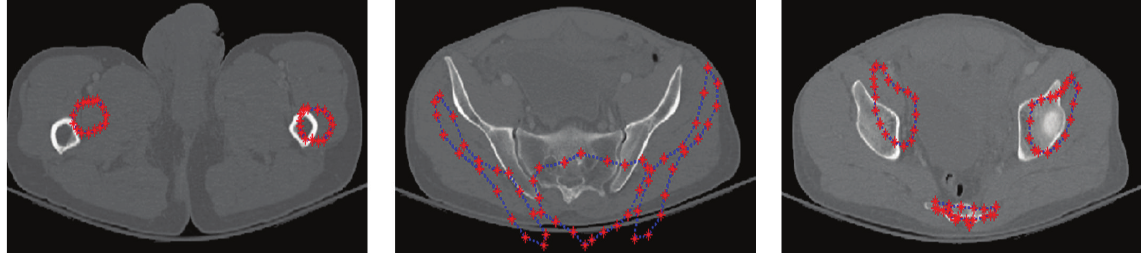
Figure 7: Example results of pelvic bone segmentation via standard ASM without initialization.